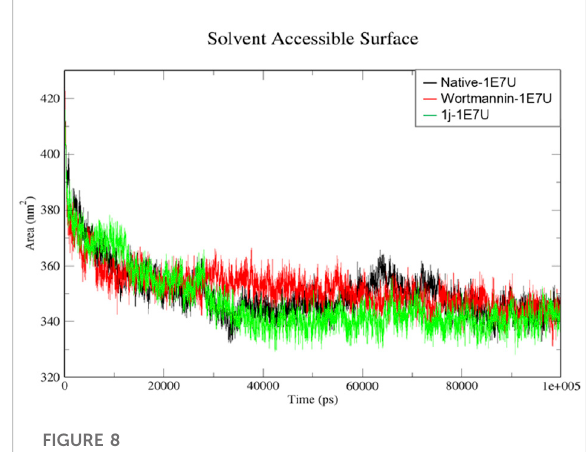
FIGURE 6 RMSFanalysisforthenativestructureof1E7Uanditscomplex with wortmannin (red) and 1j